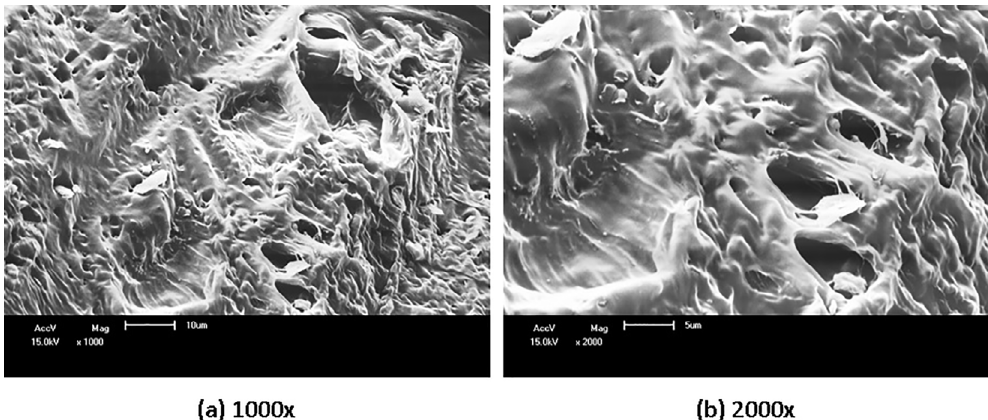
Figure 8. SEM images of PCL/CLNa in different magnifications, on the Figure 8a with magnification of 1000x and the Figure 8b with magnification of